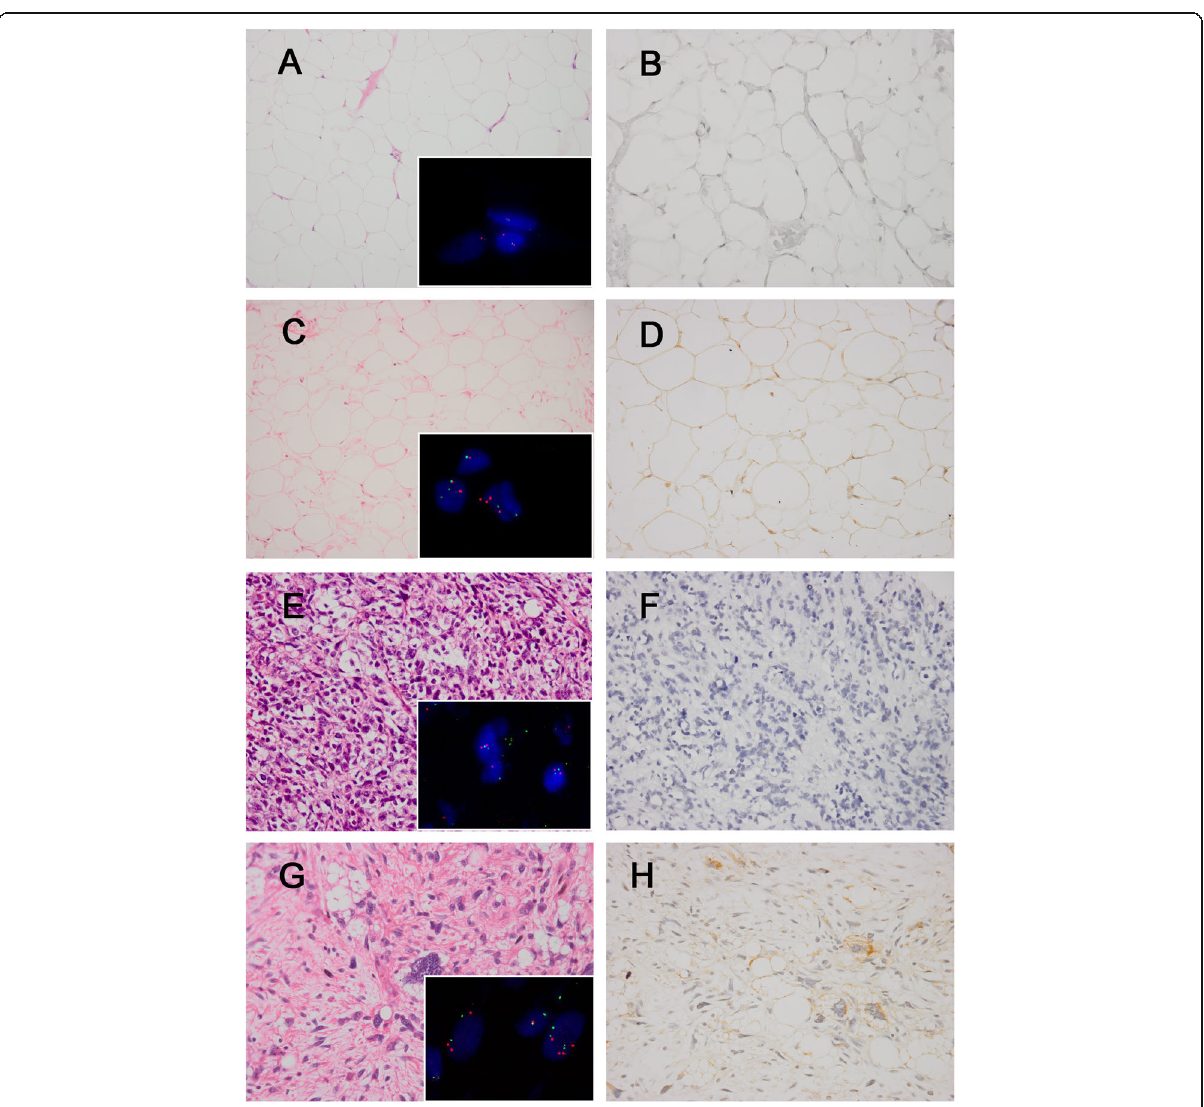
Fig. 3 The histologic features of control tumors and corresponding FRS2 FISH and FRS2 immunohistochemical staining results. Lipoma( a ) without FRS2 gene amplification ( inset ) was FRS2 immunostaining negative ( b ). Lipoma( c ) without FRS2 gene amplification ( inset ) but exhibited 1+ FRS2 expression ( d ). Pleomorphic liposarcoma( e ) was FRS2 nonamplified ( inset ) and negative for FRS2 immunostaining ( f ). Pleomorphic liposarcoma( g ) without FRS2 amplification showing polysomic for CEP12 ( inset ), and had 1+ FRS2 staining ( h ). Red signals represent FRS2 . Green signals represent chromosome12 centromeres. (a, c, e, g, haematoxylin and eosin; b, d, f, h, immunostaining) (original magnification, a, c × 200, b, d-h ×